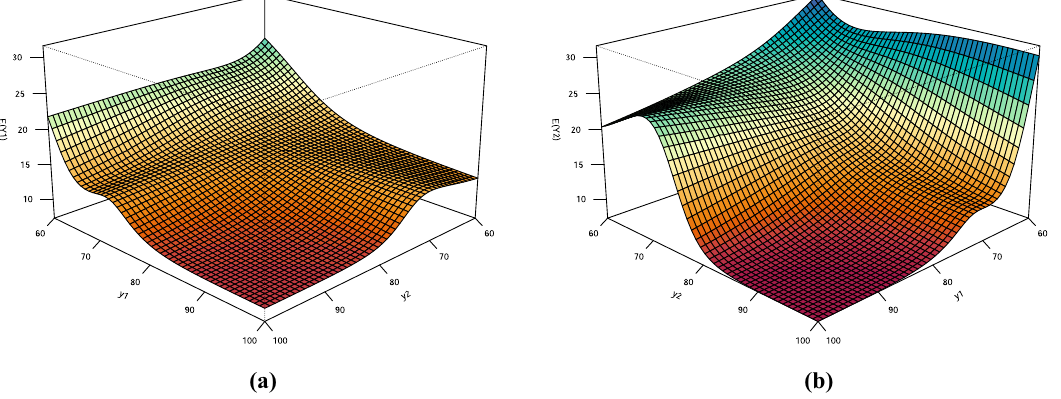
Figure 9: Marginal expected excess survival times as a function of men ’ s age y